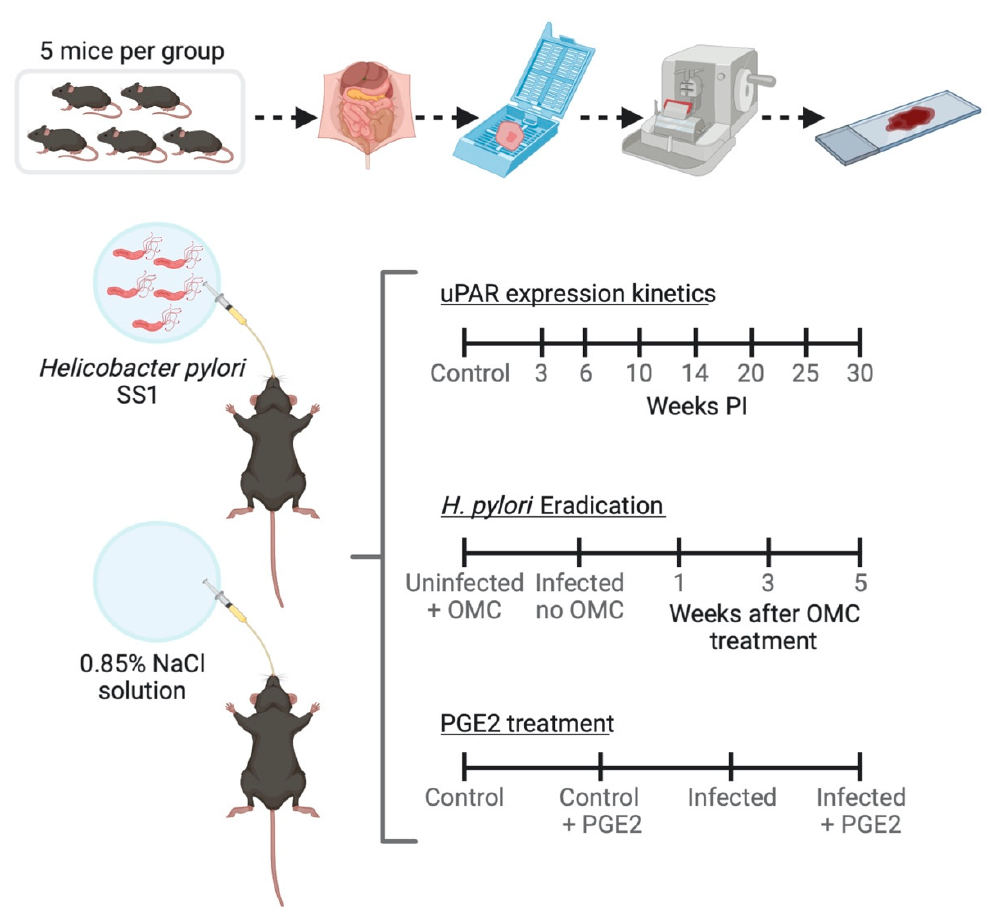
Figure 1. Schematic view of the experiments performed on a mouse model of Helicobacter pylori -induced gastritis. OMC; omeprazole, metronidazole, clarithromycin; PGE2; Prostaglandin E 2 (created with BioRender.com).